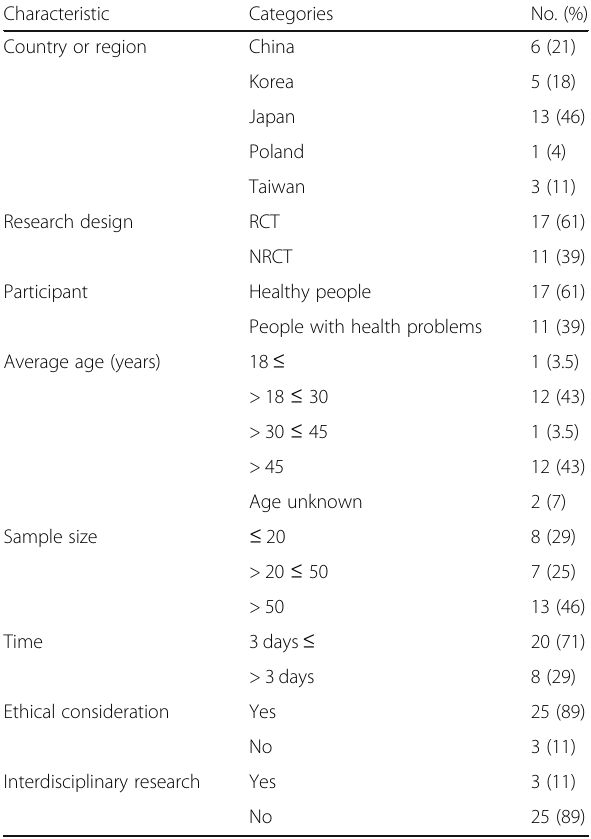
Table 1 General characteristics of included studies ( n = 28)